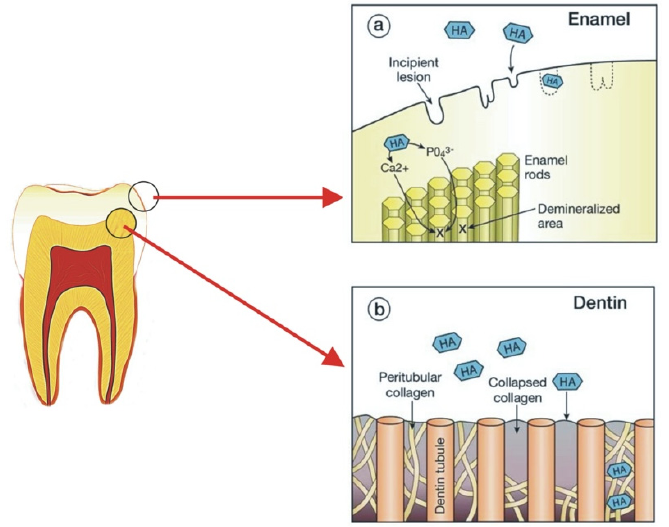
Figure 2. The mechanism of action of HA on the remineralisation of enamel ( a ) and dentine ( b ). In enamel, HA penetrates into porosities to replace dissolved phosphate and calcium ions and forms a layer of synthetic enamel on the tooth surface. In dentine, nano-HA penetrates into the demineralised collagen matrix acting as a scaffold for remineralisation and provides a good source of calcium locally.